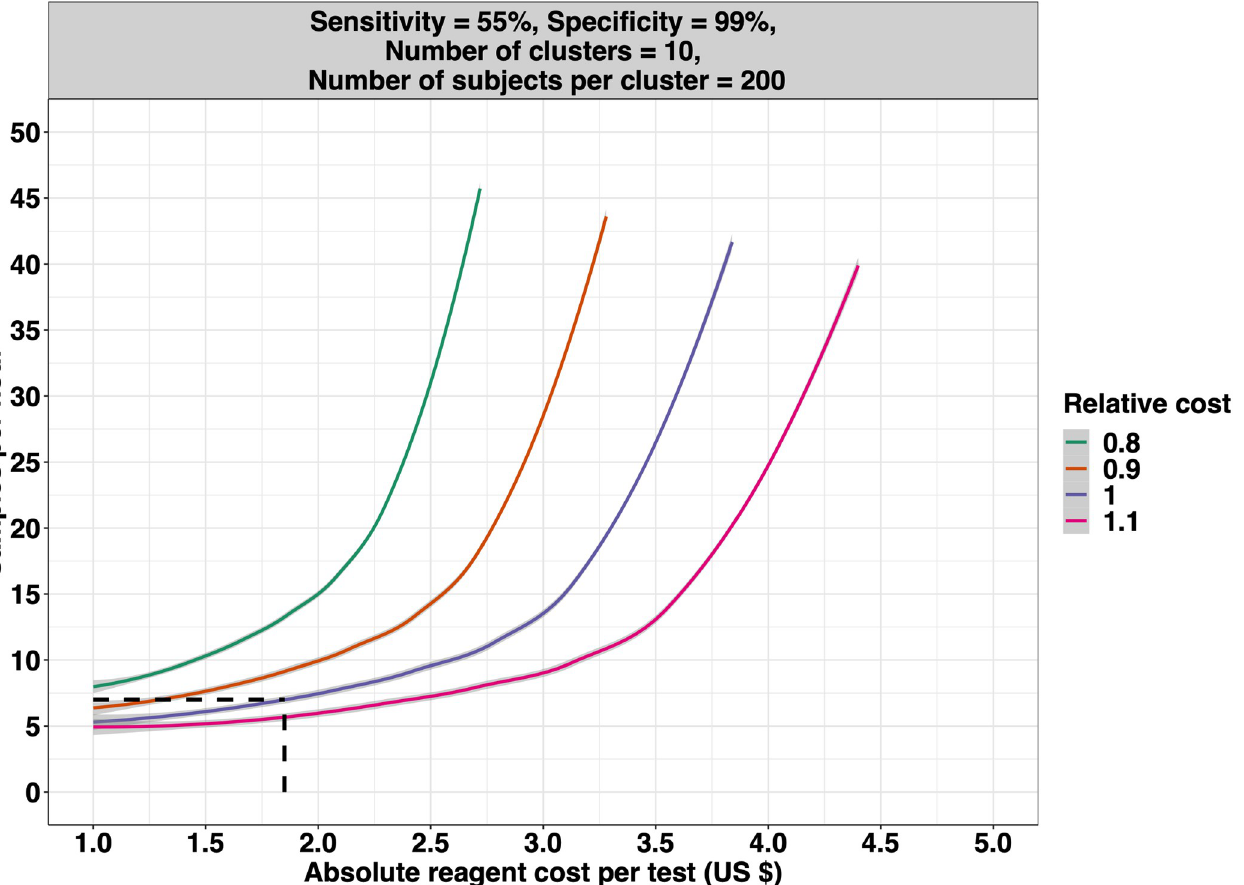
Fig 9. The relative total survey cost of Kato-Katz thick smear with improved specificity. The contour lines illustrate the total survey cost when applying a Kato-Katz thick smear with improved specificity KK ( se = 55 %, and sp = 99 %) with varying sample throughput and reagent cost to test one sample sp kksp kksp relative to the total cost of a survey based on the soil-transmitted helminths target product profiles diagnostic performance D tpp 1 ( se tpp 1 = 60 % and sp tpp 1 = 99 %) with sample throughput (7 samples per hour per person) and cost characteristics ( 3 US $ reagent test cost). The dotted line indicates the maximum reagent cost per test for the improved Kato-Katz thick smear ( 1.85 US $) when the sample throughput was set at 7. The intra-cluster correlation ρ i was set at 0.02 and the number of clusters at 10. The number of subjects per cluster was estimated as the required minimum number of subjects for adequate decision- making ( E = 25 % and E = 5 %) around a program prevalence threshold of 2%, with the grey zone defined as T ± 50 % ( LL = 1 %and UL = 3 %). The overtreat undertreat total survey cost was defined as the minimal cost required. The graph was based on 10,000 Monte Carlo simulations.